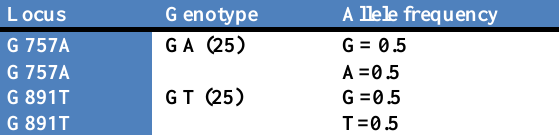
Table, 6: The allelic and genotypic frequencies for sequence polymorphisms in the GnRHR gene in sheep. Locus